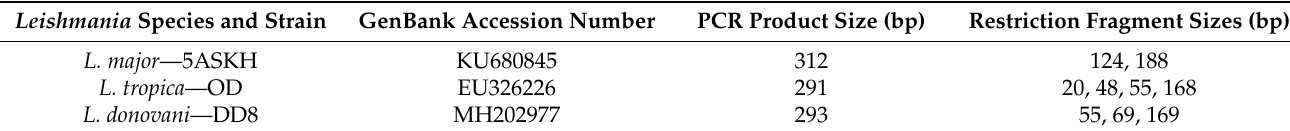
Table 2. Fragment size of Leishmania ITS genes generated by digestion with Hae III.